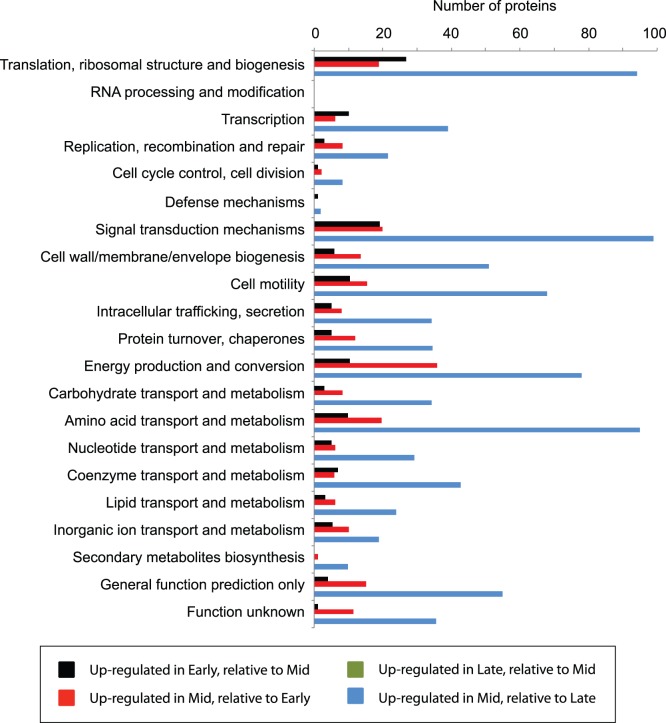
Significant shifts in protein abundances between the three stages of carbon amendment, binned into COG categories.Significant protein abundance increases and decreases between the stages were inferred using Z-score calculations.